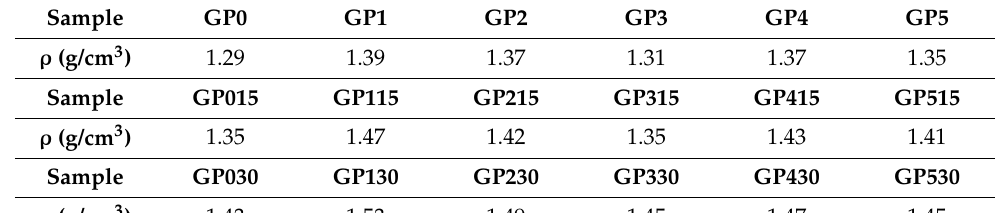
Figure 7. Comparison of morphological integrity of PSAN cylinders after being subjected to four thermal cycles.